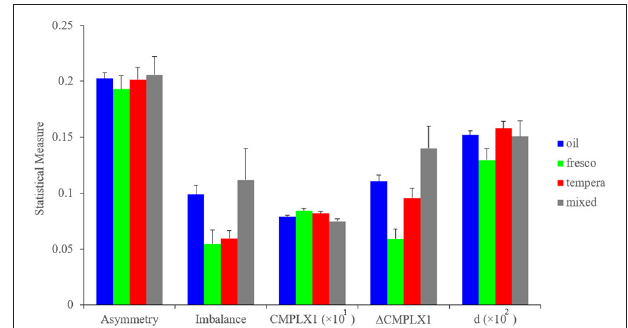
FIGURE 7 | Measures of asymmetry, imbalance, and complexity as a function of the painting medium. Horizontal-axis categories are as in Figure 6 , except for d, which is Short-range Distance presented as the percentage of the size of the canvas (defined in Figure 1 from Equation 12). These statistical measures are shown as means and standard errors. The measures show that during the Early Renaissance, painting media affected some fluency variables (e.g., balance, Complexity of Order 1, 1 Complexity, and Short-range Distance). However, the painting media did not affect all variables